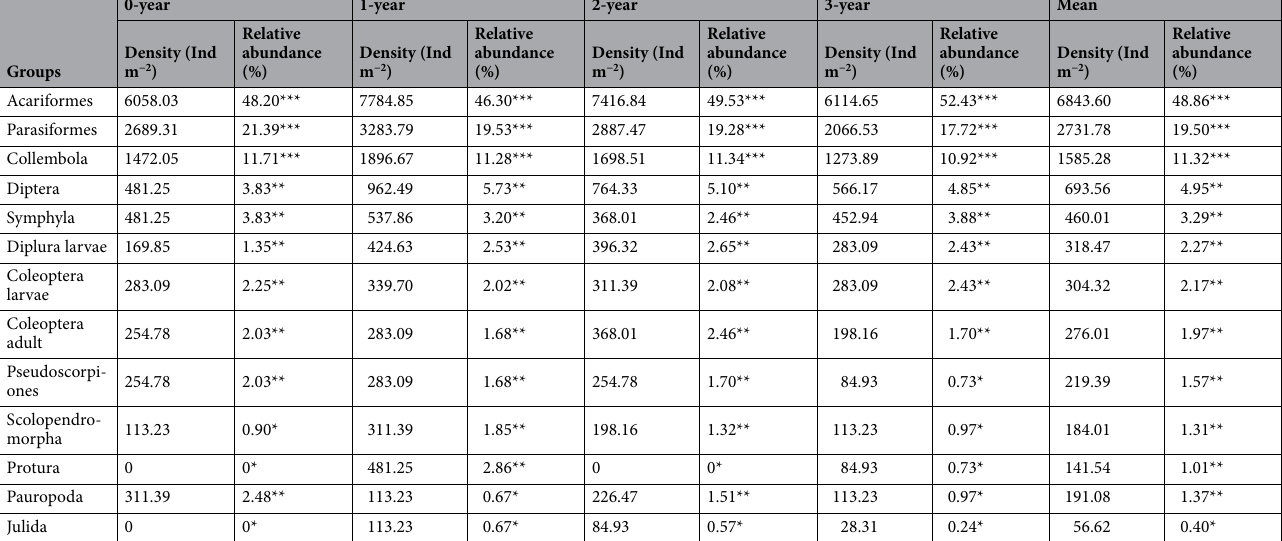
Table 1. Composition of soil meso- and micro-fauna in different sampling times. *Rare groups, **Common groups, ***Dominant groups. 0-year, 1-year, 2-year and 3-year represent before planting, planting for 1 year, 2 years and 3 years, respectively.